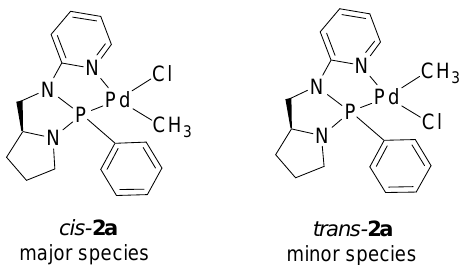
Figure 2. The cis and trans isomers of complex 2a